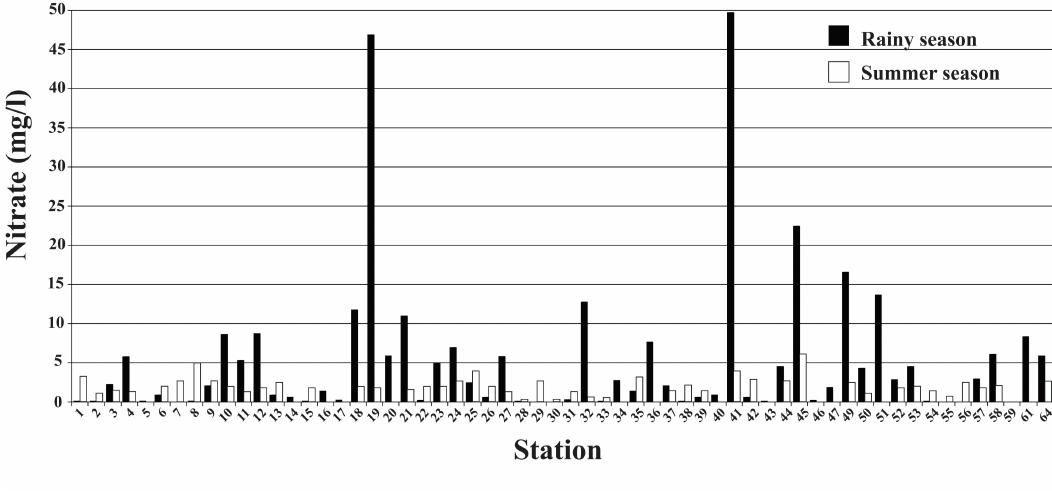
Figure 6. NO 3 − concentrations in both rainy and summer seasons of study area at Cha Am district, Phetchaburi